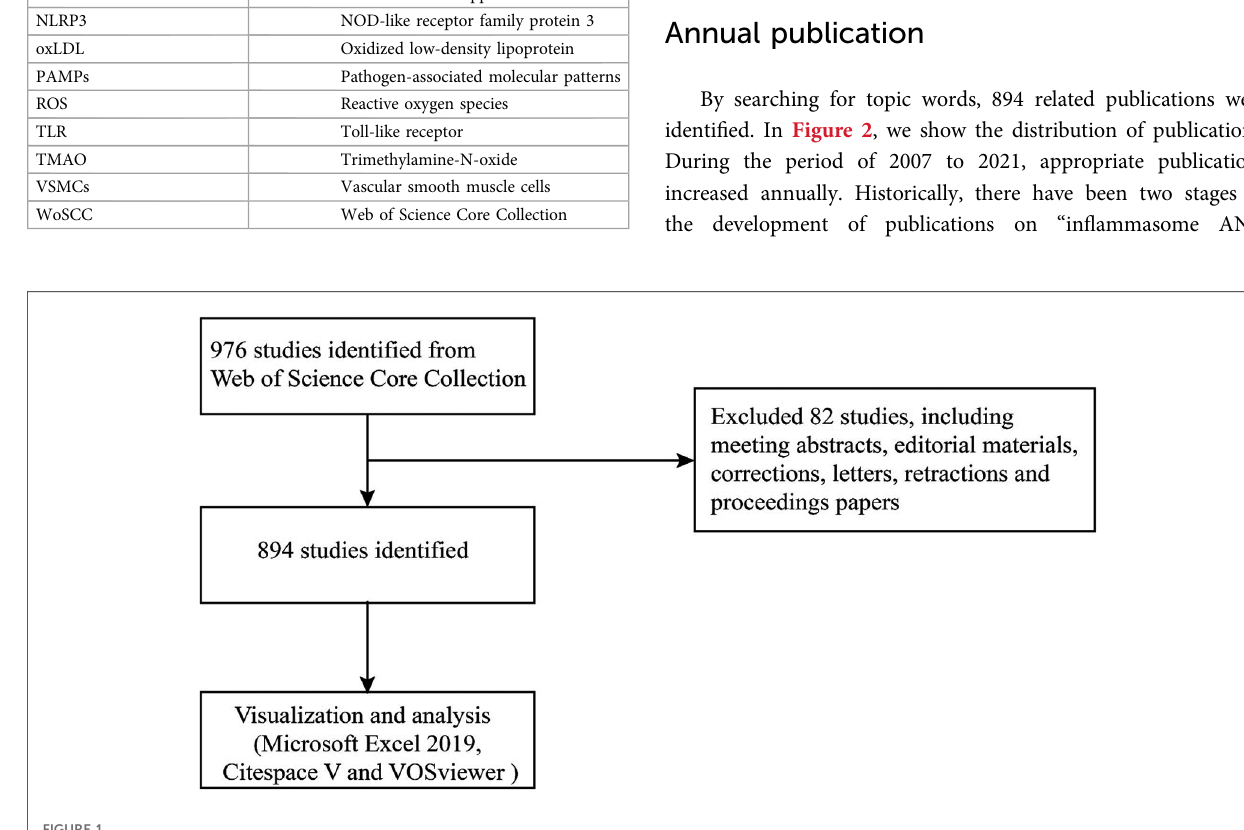
FIGURE 1 Flowchart of literature selection.